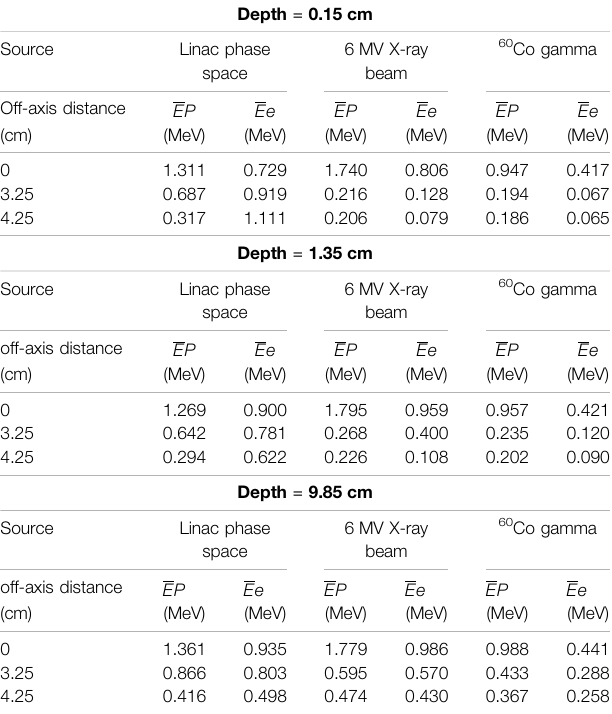
TABLE 6 | Mean photon and electron (TEF) energy at several water depths and OADs for the 6 MV X-ray phase space, 6 MV X-ray point source, and 60 Co gamma beam: EP is the average photon energy, while Ee corresponds to the